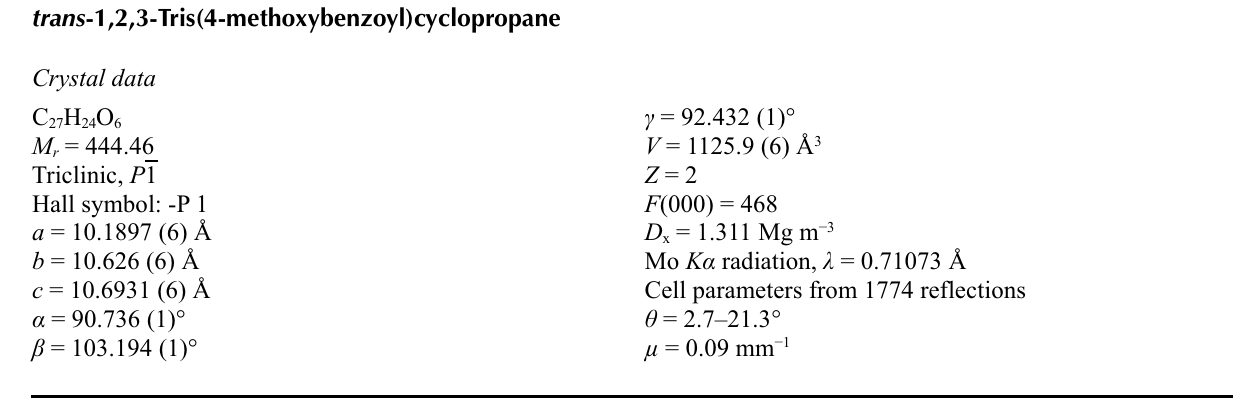
The molecular structure of the title compound with the atom–numbering scheme. Displacement ellipsoids are drawn at the 30% probability level. H atoms are presented as a small spheres of arbitrary